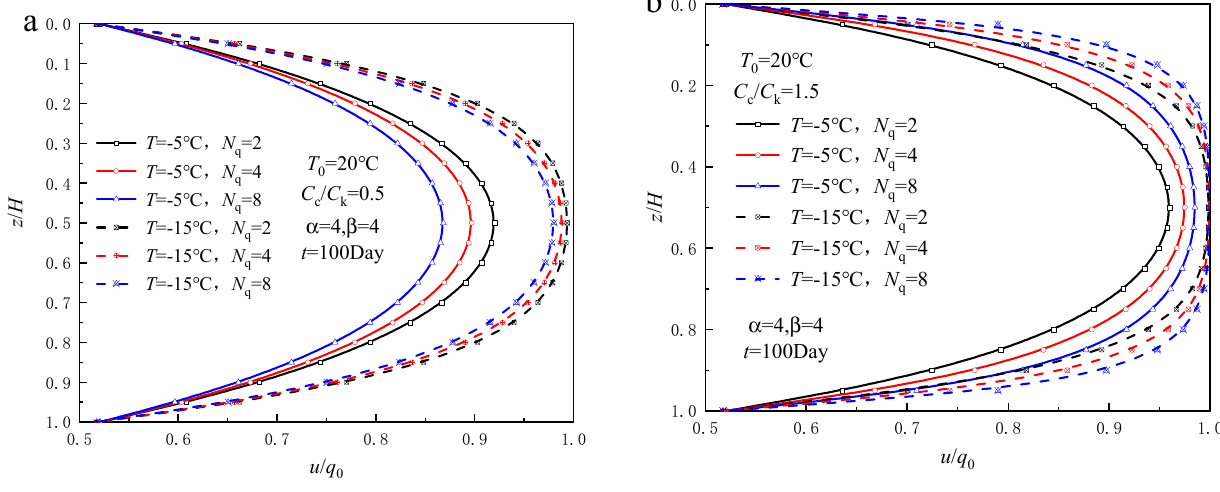
Figure 5. Influence of N q : ( a ) the distribution of excess pore water pressure ( C c / C k < 1), and ( b ) the distribution of excess pore water pressure ( C c / C k >